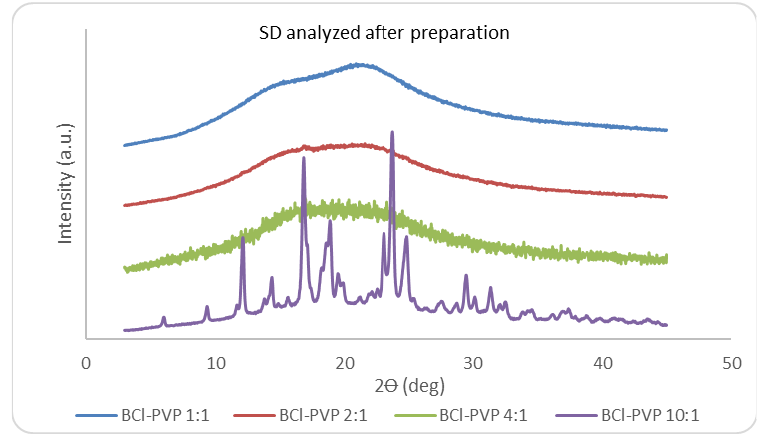
Figure 2. X-ray pattern of bicalutamide from the 1:1, 2:1, 4:1, 10:1 solid dispersions. The results were obtained for freshly prepared powder samples.